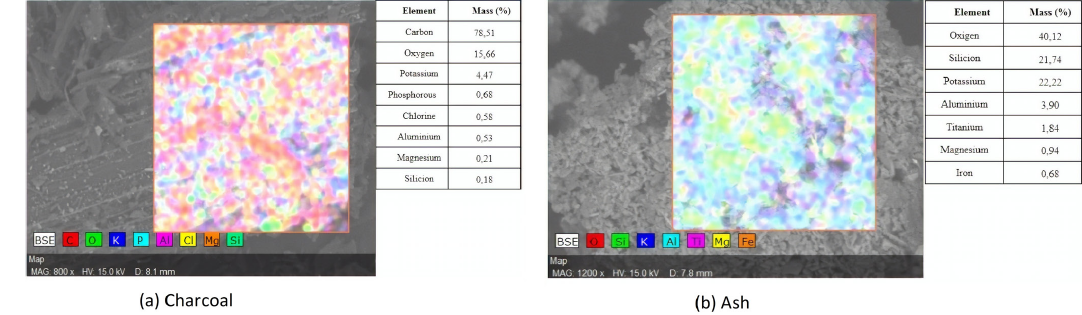
Figure 4. SEM / EDS for elephant grass charcoal and its ash.